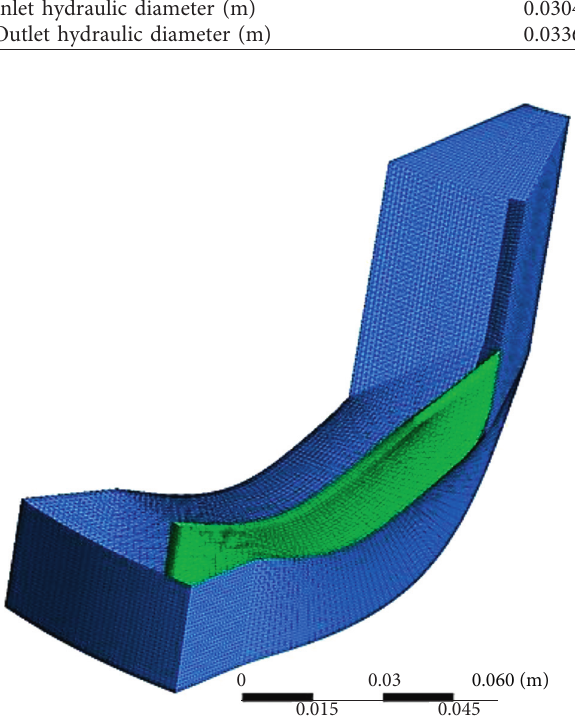
Figure 3: Mesh for a blade of compressor with fluid around it.